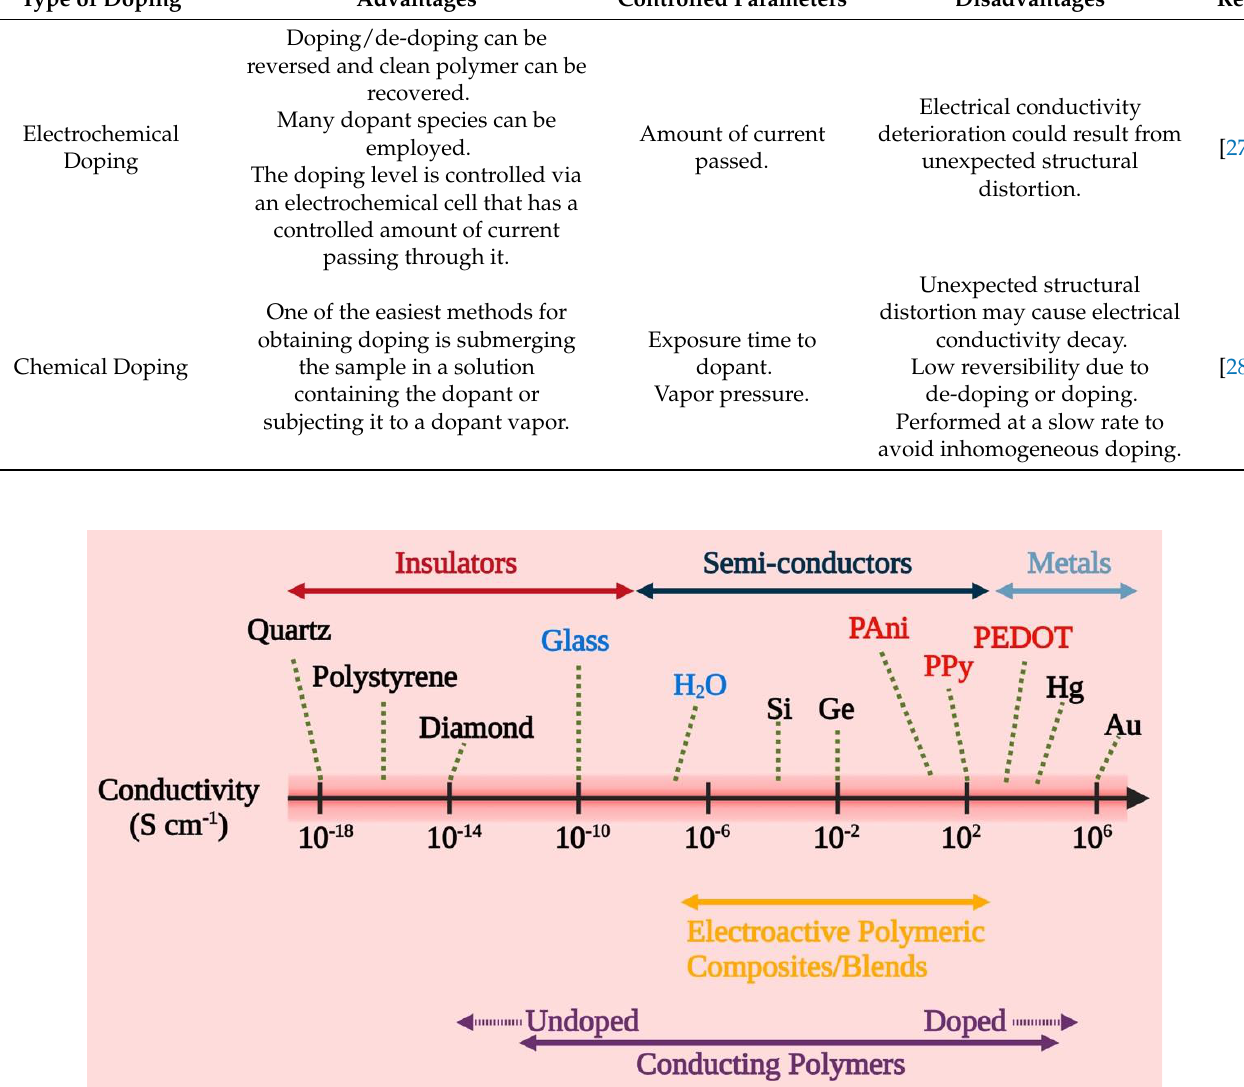
Figure 3. Conductivity range and conductivity-based classification of CPs and CP composites into insulators, semiconductors, and metals.